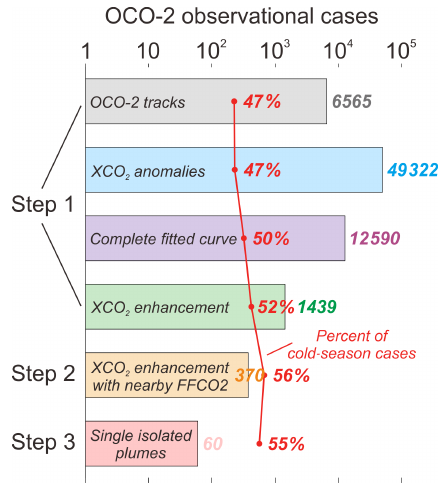
Figure 1. OCO-2 XCO 2 observational cases contained in each pro- cessing step. Step 1 starts from 6565 OCO-2 tracks around and over China between September 2014 and August 2019 (grey bar) and finds 49322 XCO 2 anomalies along the OCO-2 tracks (blue bar). A total of 12590 anomalies (purple bar) and their surrounding data points within a 200km wide window can be fitted by a com- plete nonlinear curve using Eq. (1), of which 1439 XCO 2 anoma- lies (green bar) are identified as a local enhancement significantly higher than the background. Step 2 uses the Gaussian plume model to select 370 XCO 2 enhancements (yellow bar) that can be traced back to upwind fossil fuel emission sources within 50km. In step 3, we finally select the 60 cases with single isolated CO 2 plumes to quantify the CO 2 emissions. The red curve shows the percentage of cold-season observational cases in each bar. The detail of each step is described in Sect.